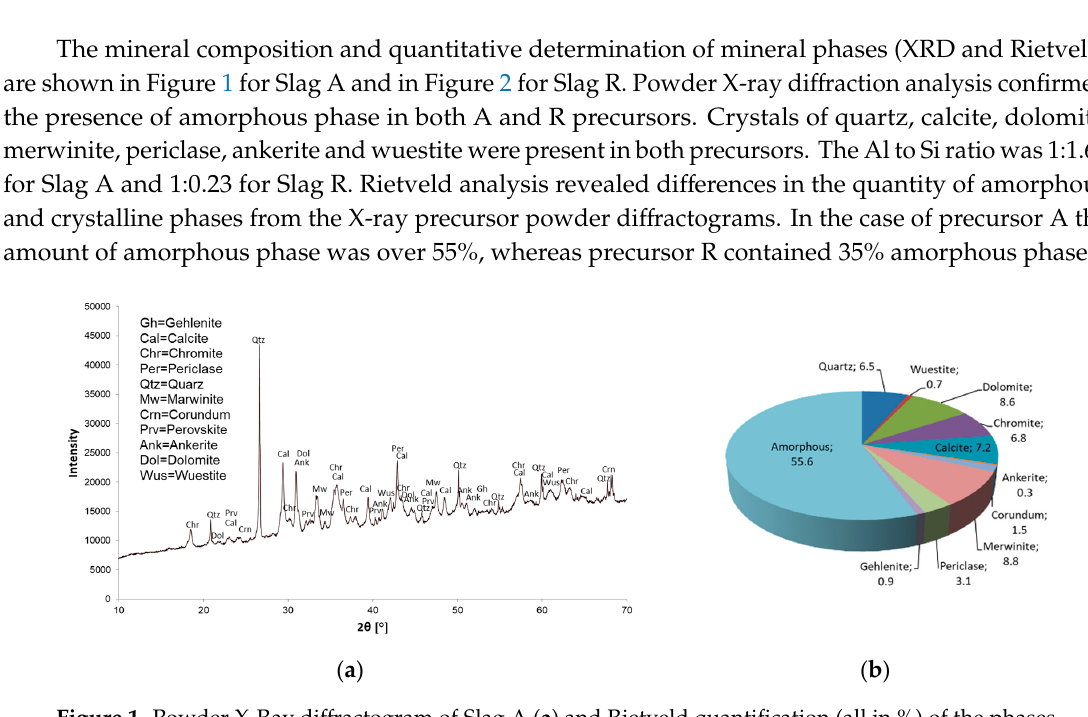
Figure 1. Powder X-Ray diffractogram of Slag A ( a ) and Rietveld quantification (all in%) of the phases in Slag A ( b ).